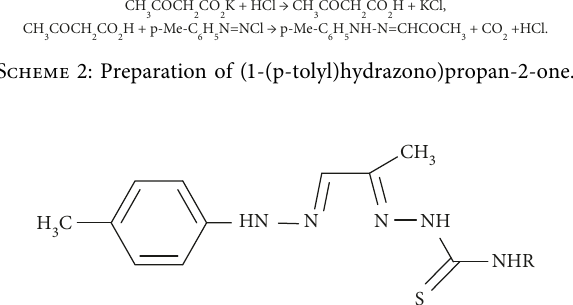
Figure 1: Structural formula for the thiosemicarbazone com- pounds. TSC1, TSC2, and TSC3 with R � H, Et, and ph,